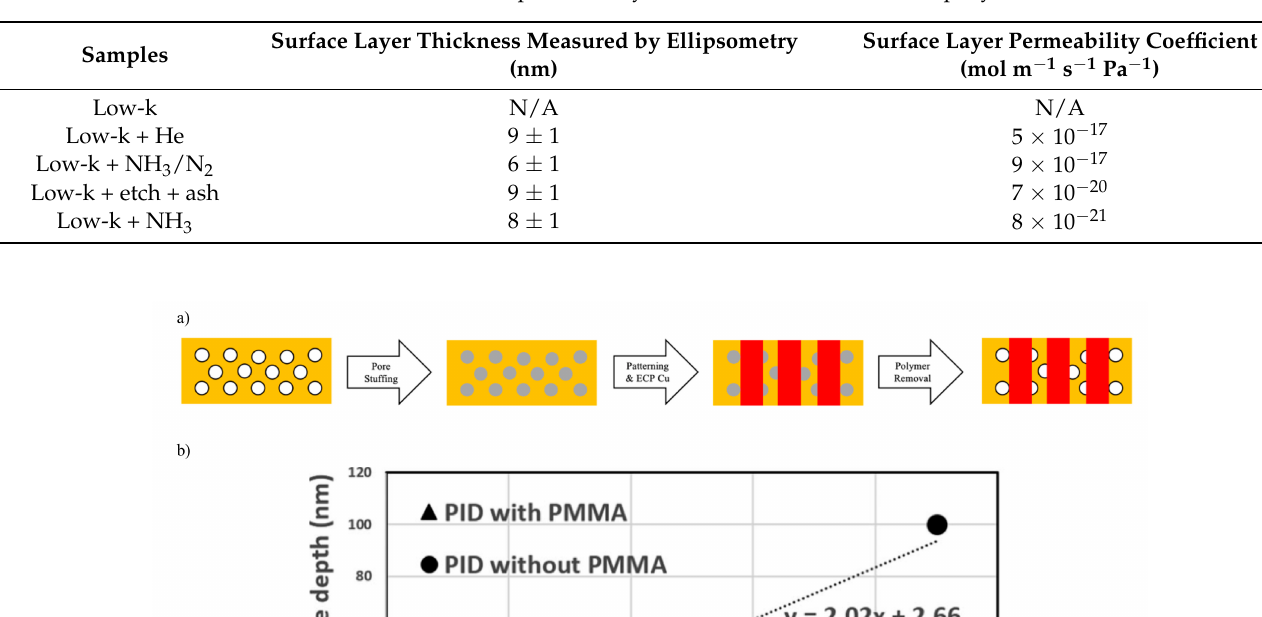
Table 8. Thickness and permeability coefficients of the modified top layer.